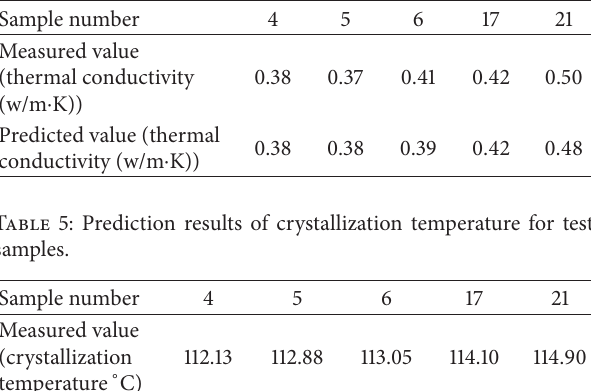
Table 6: Experimental and predicted degradation temperature for test